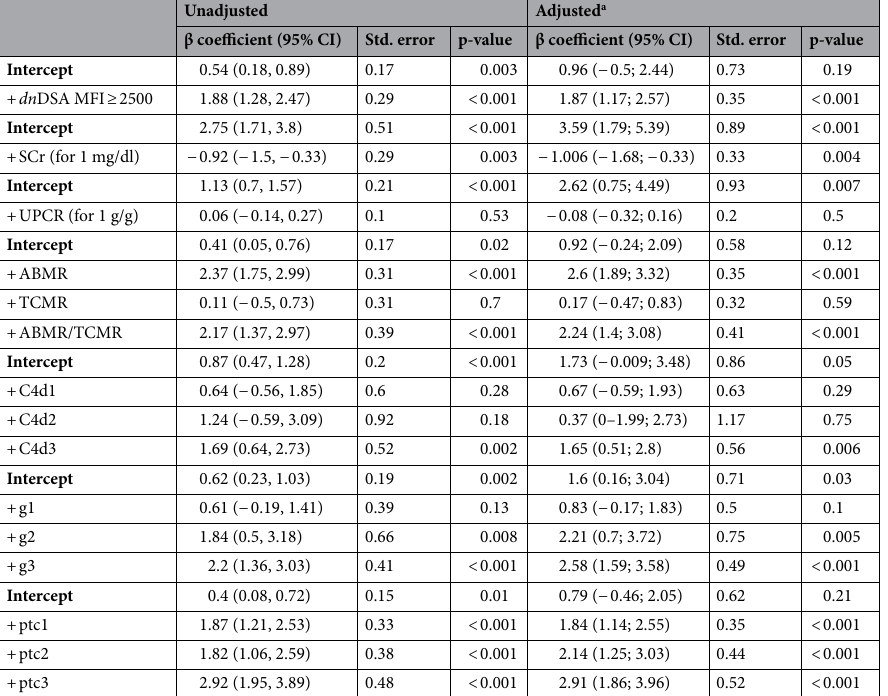
Table 5. Linear regression to evaluate determinants of absolute dd-cfDNA values. dd-cfDNA, donor-derived cell-free DNA; dn DSA, de novo donor-specific antibody; MFI, mean fluorescence intensity; AMR, antibody- mediated rejection; TCMR, T-cell mediated rejection; UPCR, urine protein:creatinine ratio; SCr, serum creatinine; g, glomerulitis; ptc, peritubular capillaritis. a After multivariate adjustment for age, race, gender, type of transplant ,FK level and time